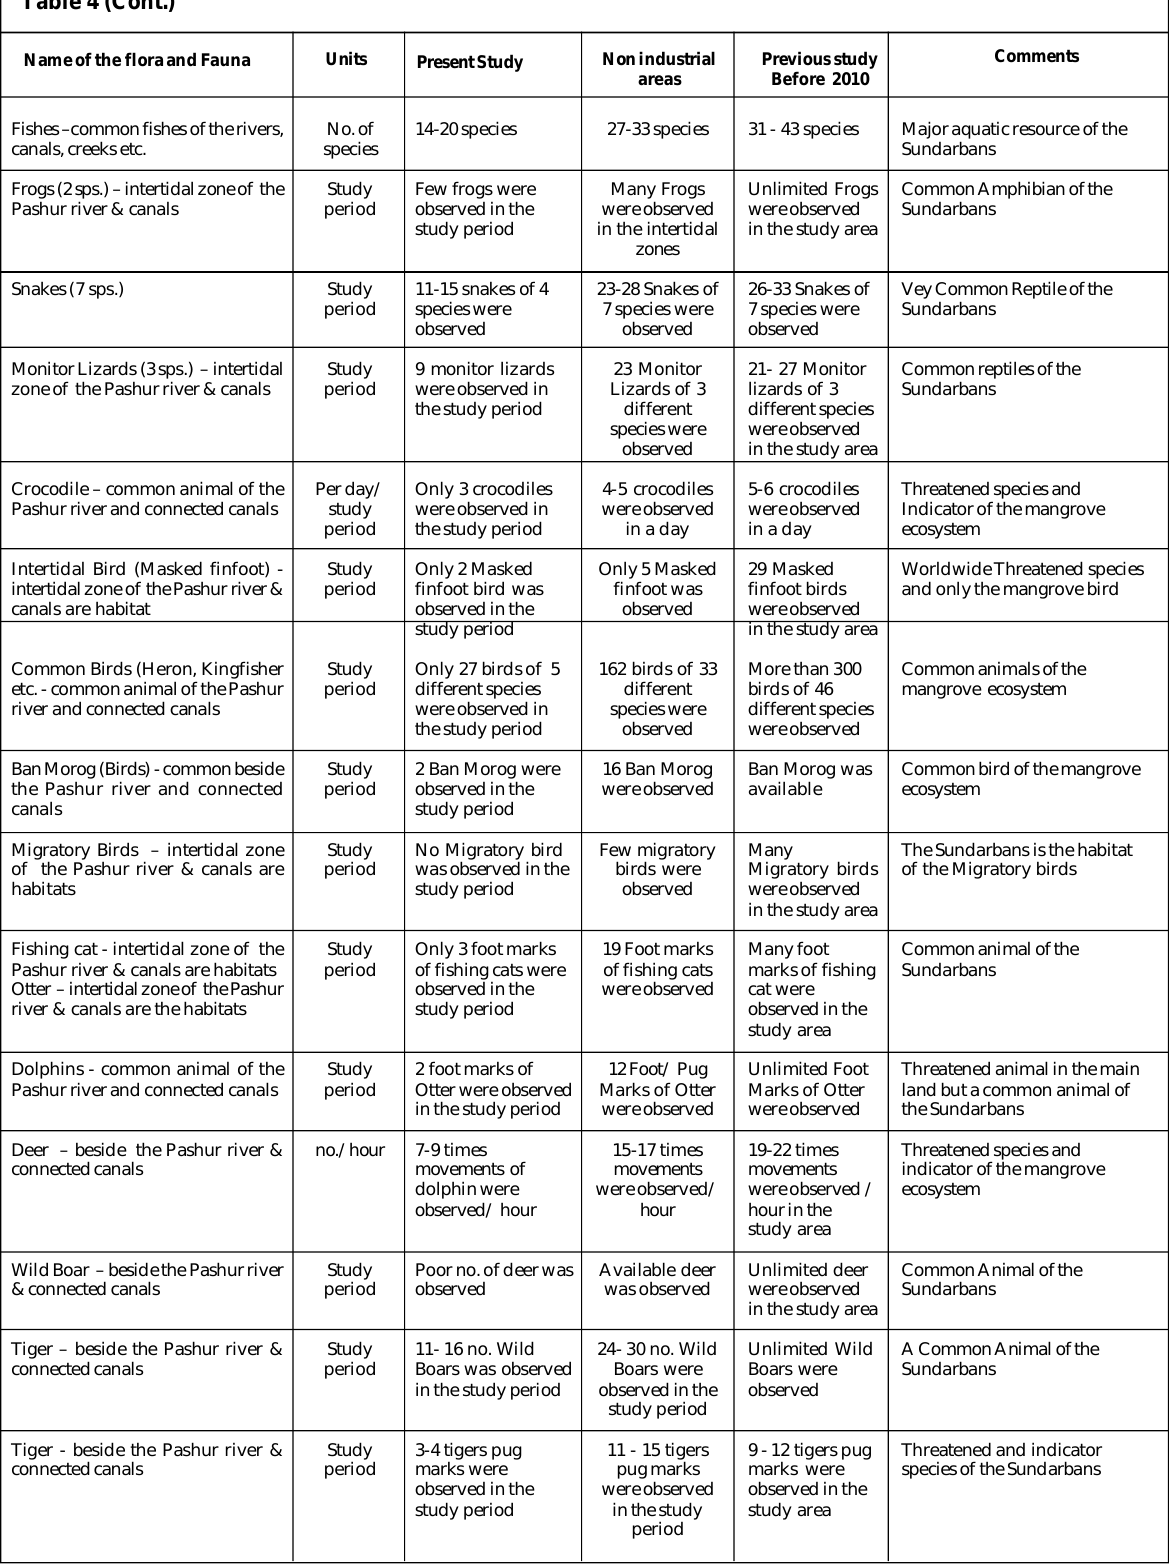
Table 4 (Cont.) Name of the flora and Fauna Fishes –common fishes of the rivers, canals, creeks